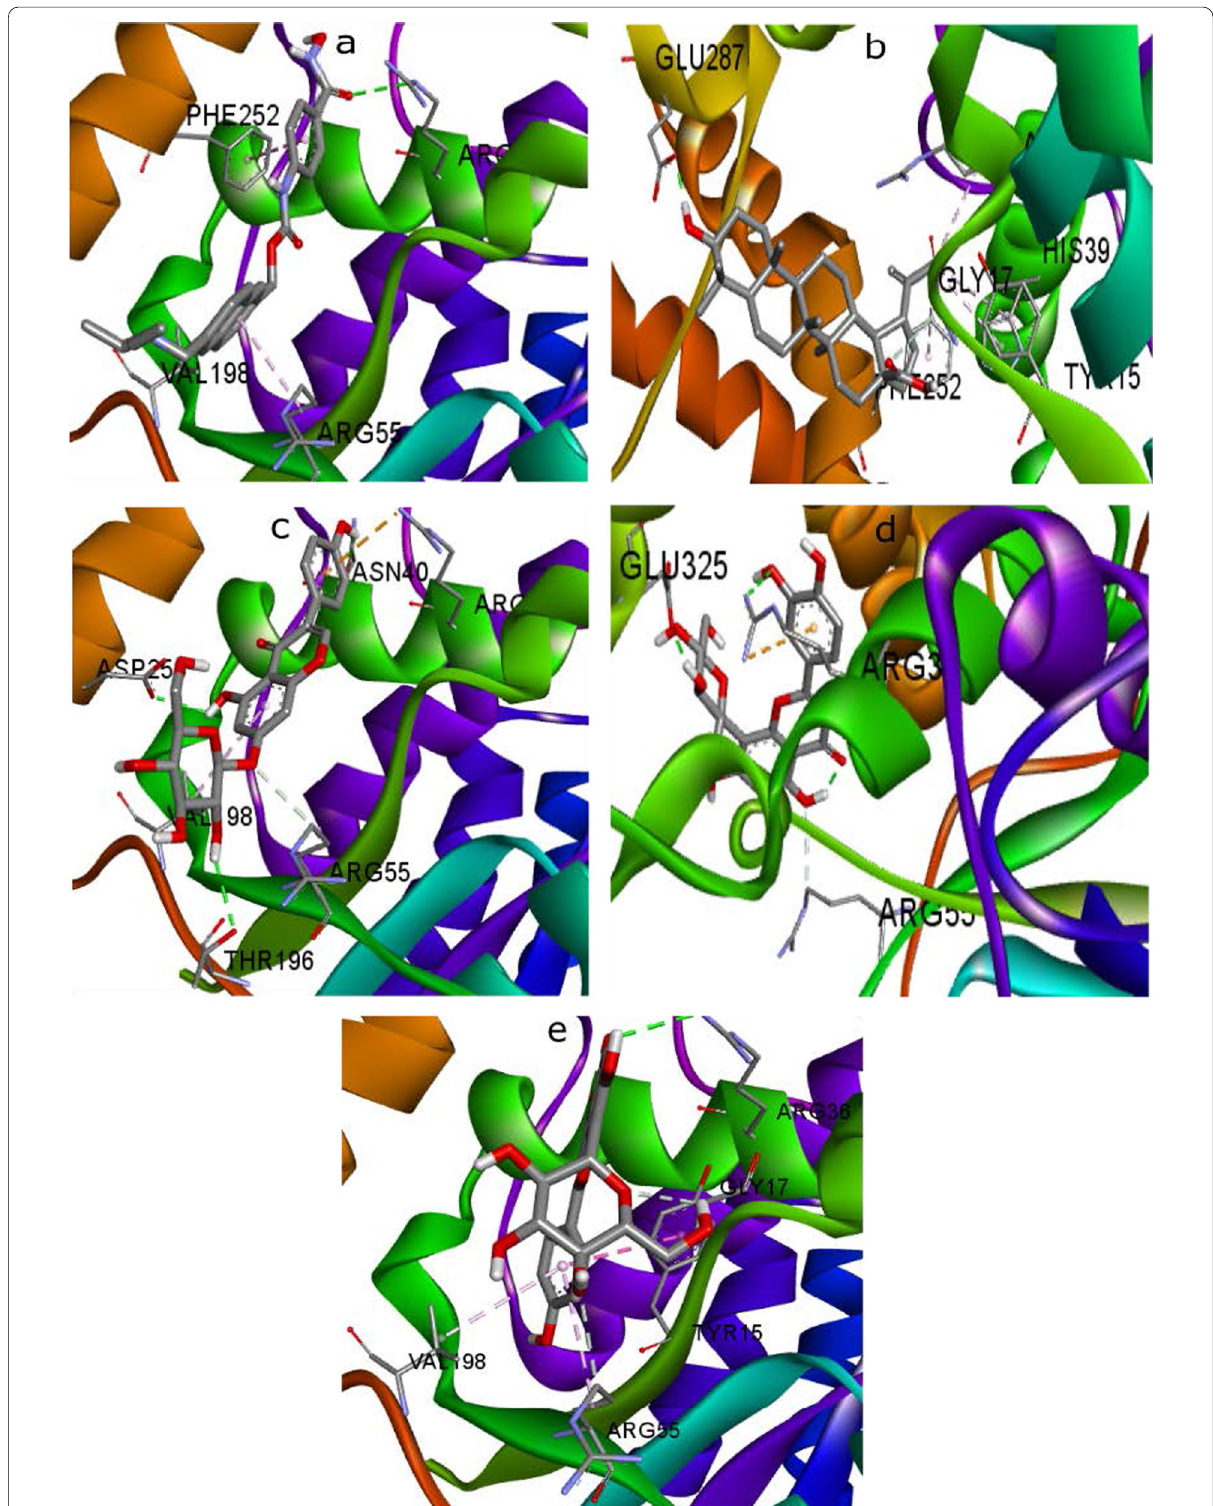
Fig. 1 3D view of the interaction between a givinostat b betulinic acid c genistin d orientin e vitexin and the binding sites in histone deacetylase